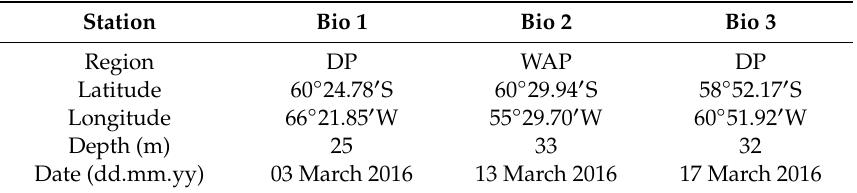
Table 1. Details of the sampling stations during the RV Polarstern oceanographic expedition PS97. DP and WAP refer to the Drake Passage and Western Antarctic Peninsula,